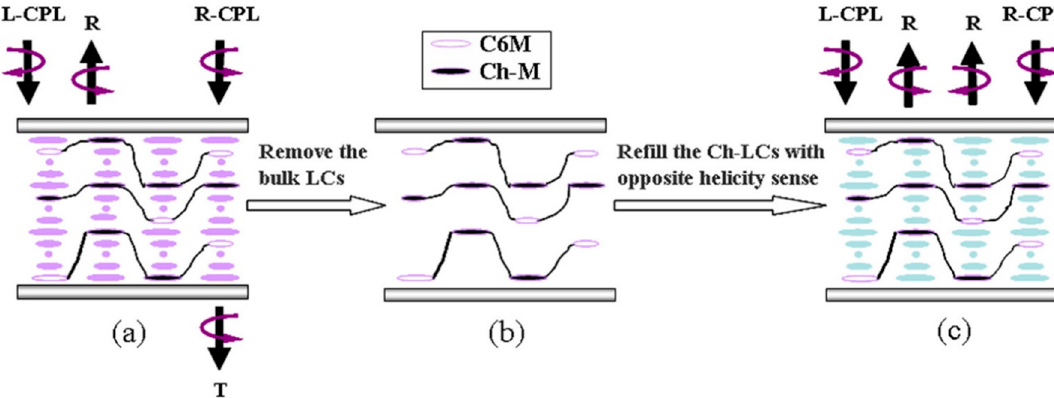
nematic templated film. L-CPL: Left circularly polarised light. R-CPL: right circularly polarised